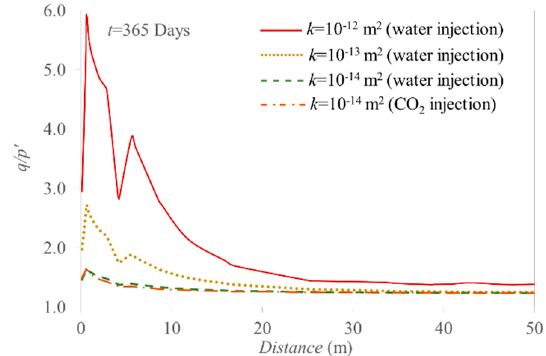
Figure 14. 𝑞/𝑝′ trajectory in the horizontal direction at the depth of the injection point when cold water or CO 2 are injected during 1 year. Note that the internal friction angle of the reservoir matrix is higher than that of pre-existing fractures and thus, the failure thresholds are different in fractures and reservoir matrix.